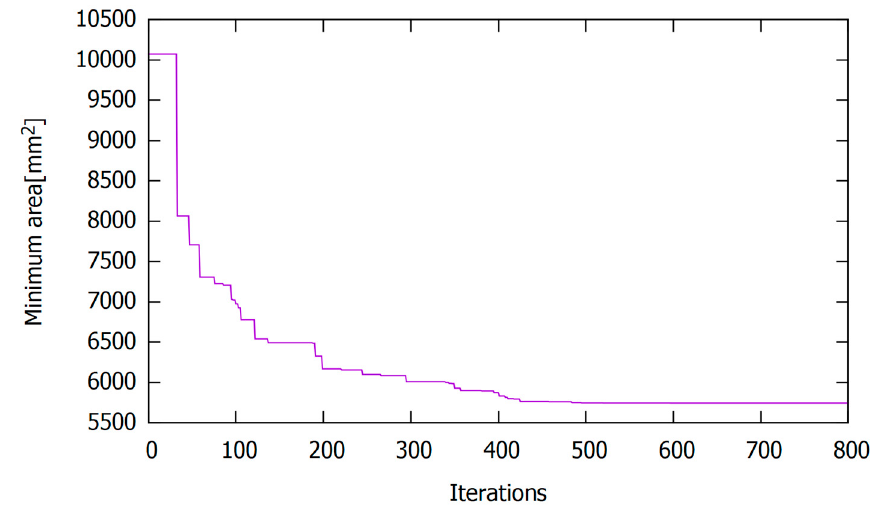
Figure 5. Variation in the minimum cross-sectional area of the slender web in the first 800 harmony search iterations . Table 3. Geometric and mechanical properties of the optimised cross-section with slender web.